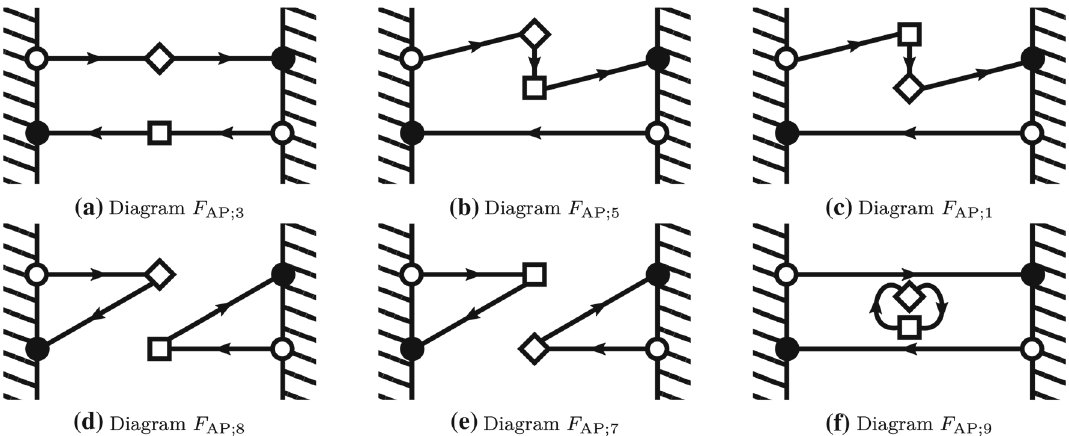
Fig. 2 The trace diagrams contributing to the expectation values of Table 1. Conventions are similar to those of Fig. 1. The diamonds in the bulk represent the insertions of a pseudoscalar operator P ( y ) . The squares in the bulk represent the insertions of an axial current A 0 ( x ) or a pseudoscalar operator P ( x ) (giving rise to the Dirac matrices γ 0 γ 5 or γ 5 , respectively). Quark-connected diagrams F AP ; 3 , F AP ; 5 , F AP ; 1